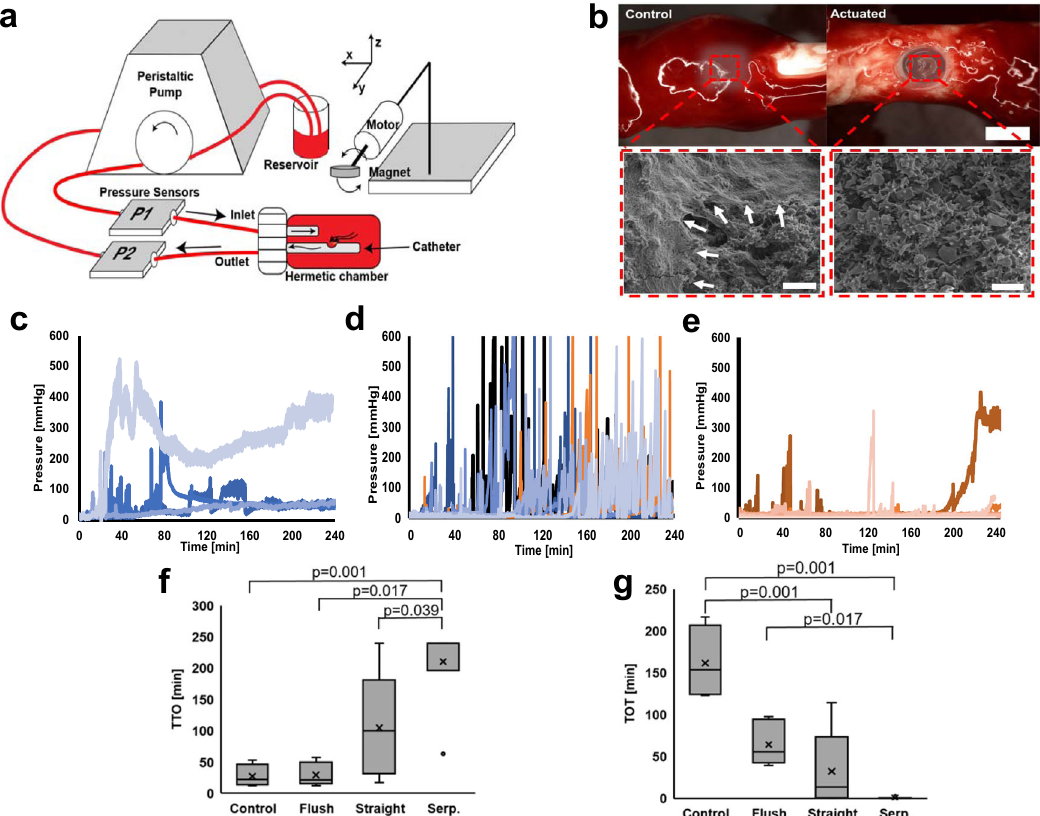
Fig. 3 In vitro experimental setup and results. a Schematic of the bench-top blood circulation and magnetic actuation setup. b A representative visual comparison of control vs. actuated self-clearing catheter at the conclusion of the experiment. Scale bar = 1.5 mm. Inset: SEM images obtained from hematoma fragments of the control group. White arrows depict the robust fi brin network left unscathed and covering red blood cells. The hematoma fragments of the actuating group lack the fi brin network surrounding the red blood cells ( n = 1, each). Scale bar = 10 μ m. c Differential pressure (P2 – P1) recording of all control catheters ( n = 4). d Differential pressure (P2 – P1) recording of all fl ushing catheters ( n = 6). Note the frequent pressure spikes associated with each fl ushing. e Differential pressure (P2 – P1) recording of all self-clearing catheters ( n = 11). The fi gure includes data from fi ve straight and six serpentine devices. f Comparison of time-to-occlusion (TTO) to reach 40 mmHg between the control catheters ( n = 4), catheters that underwent fl ushing ( n = 6), and self-clearing catheters. There were two versions of self-clearing catheters with either straight ( n = 5) vs. serpentine fl exure ( n = 6) microactuators. One-way ANOVA with Tukey ’ s HSD analysis showed overall statistical signi fi cance between groups. The multiple comparisons between groups show signi fi cance as indicated. Each data point represents a different experiment using an independent sample. The box plot shows the interquartile range (IQR), the horizontal lines within the boxes are median. The x indicates the mean, and the whiskers represent the minima and the maxima of the data with outliers de fi ned as data beyond 1.5× IQR. g Comparison of the total time over the threshold (TOT). One-way ANOVA with Tukey ’ s HSD analysis con fi rmed overall statistical signi fi cance between groups. The multiple comparisons between groups show signi fi cance as indicated. The sample size for each group is the same as in ( f ) and the box plots are de fi ned in the same manner. Each data point represents a different experiment using an independent